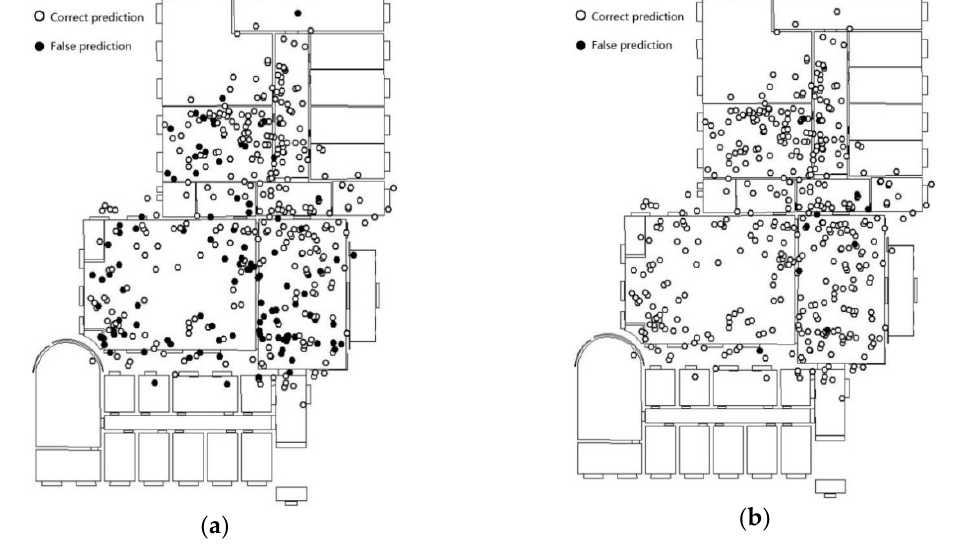
Figure 10. The prediction result in the 2nd floor of laboratory scenario. ( a ) Inception V3; ( b ) the feature fusion model.